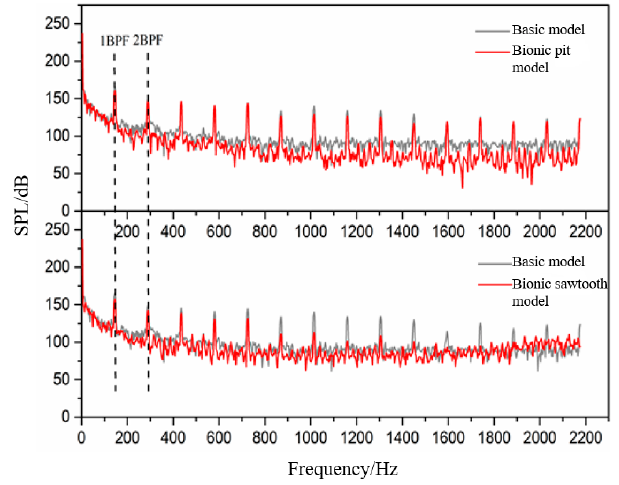
Figure 10. Frequency domain diagram of sound pressure level.